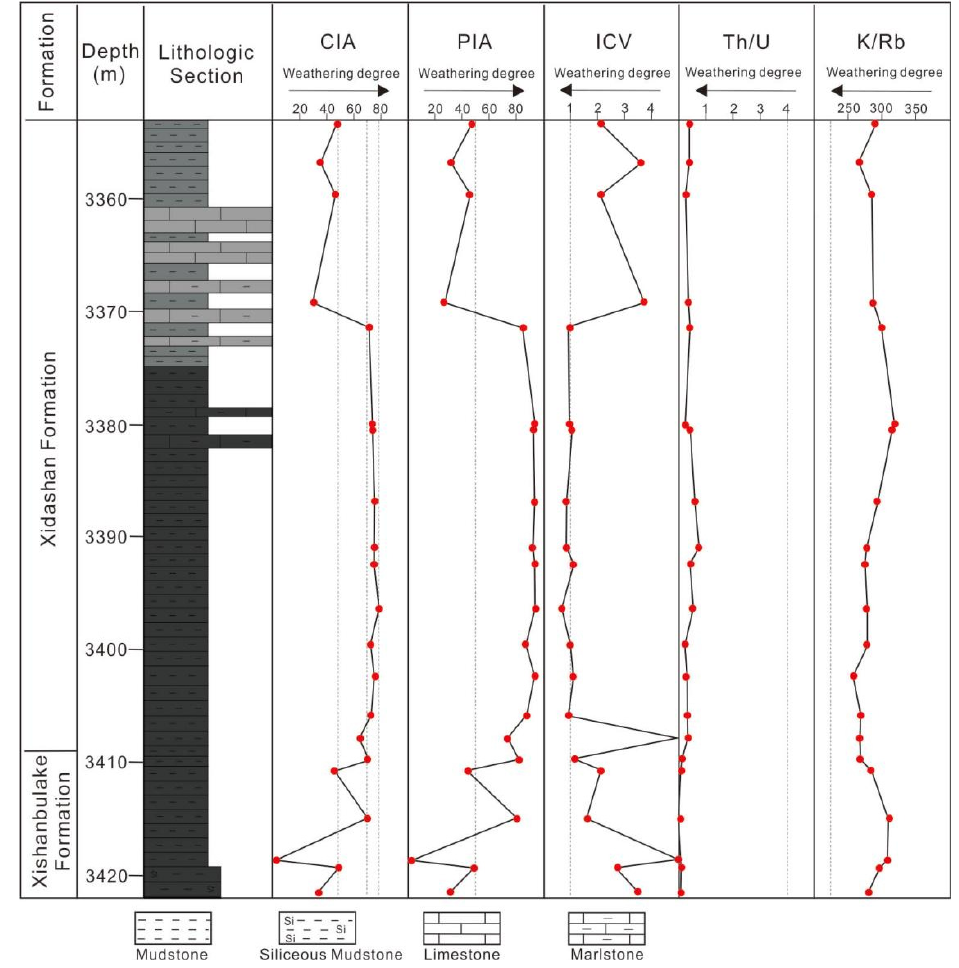
Figure 4. Chemostratigraphic profiles of the characteristics of the discrimination index of the weath- ering degree of the Lower Cambrian mudstone in the Kongquehe area.